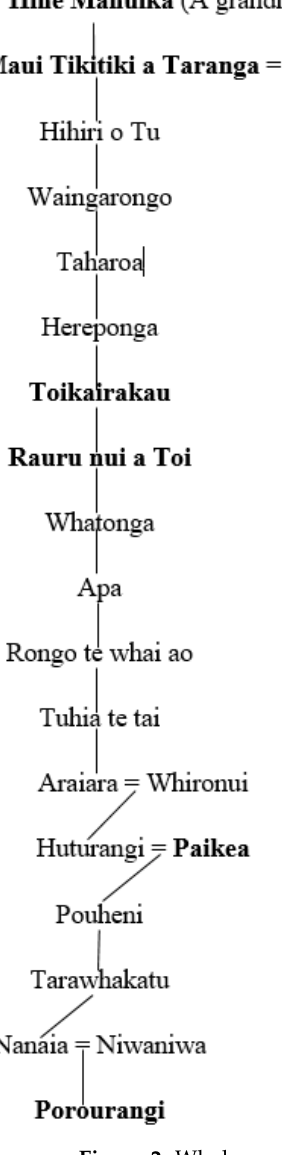
Figure 2. Whakapapa Chart 2.